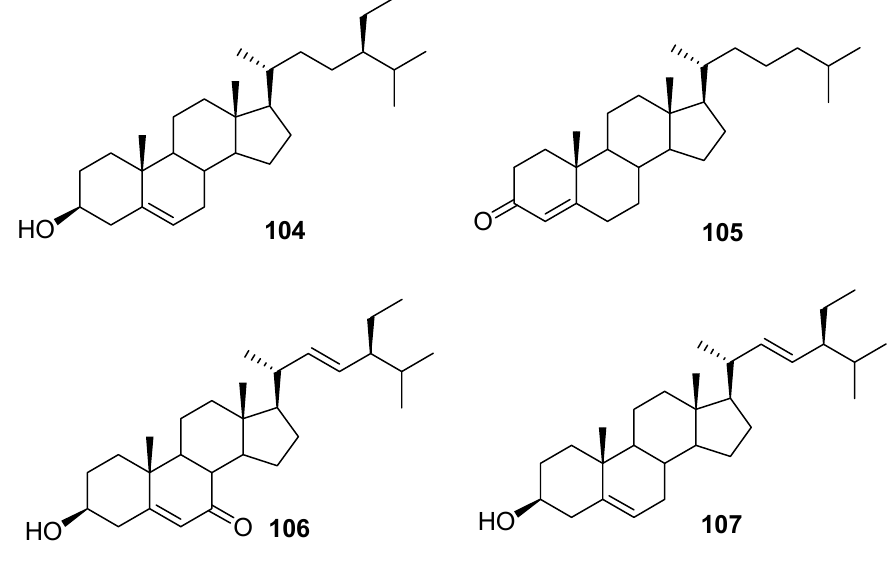
Figure 5. Chemical structures of phytosterols isolated from the genus Gnaphalium